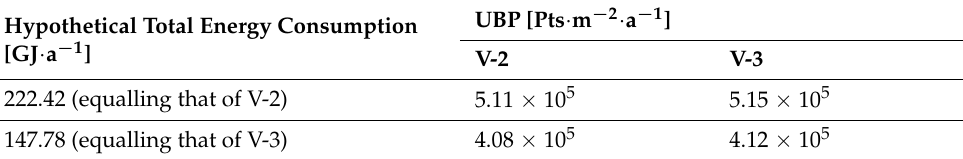
Table 4. Hypothetical overall environmental impacts (OEIs) of V-2 and V-3 recalculated per 229 m 2 treated floor area (equalling that of V-2) and total energy consumption equalling that provided in energy certificates in each